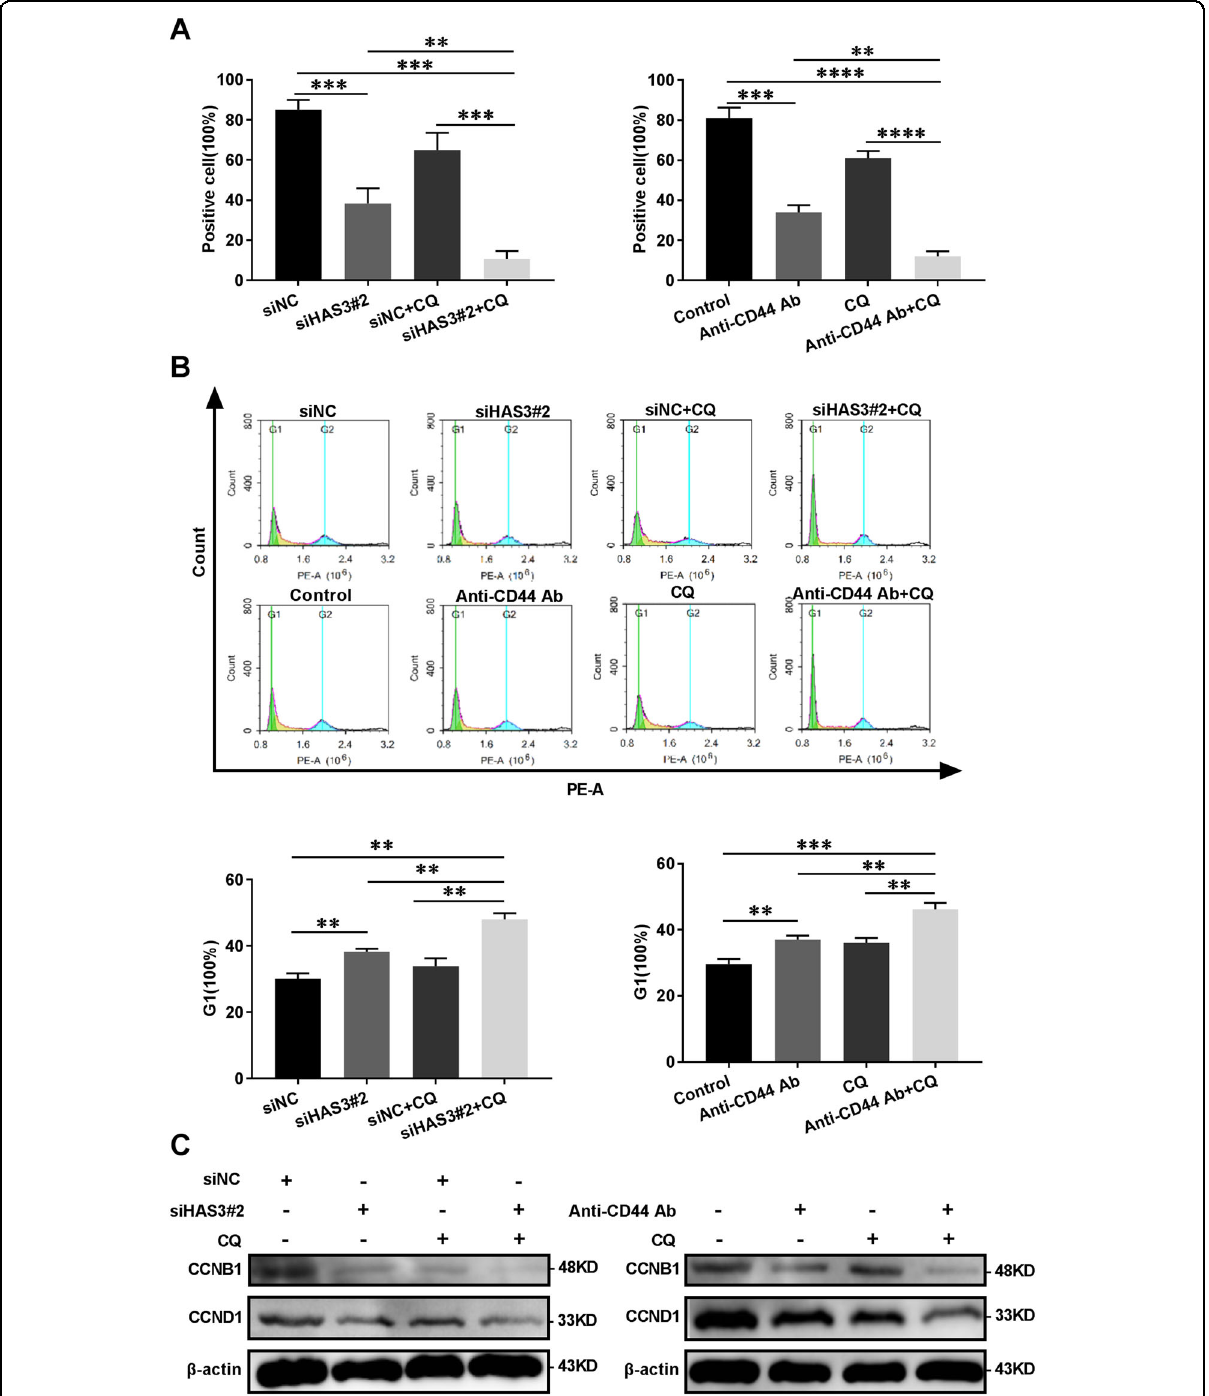
Fig. 5 Treatments interfering with HAS3 and CD44 combined with autophagy inhibitors have a synergistic effect on the glioma cell cycle. A The percentage of Ki67-positive U251 glioma cells was detected using immuno fl uorescence staining after transfection with the HAS3 siRNA or culture with a CD44 antibody, followed by treatment with CQ (30 μ mol/L) for 48 h. B The cell cycle distribution of U251 glioma cells was detected using fl ow cytometry after transfection with the HAS3 siRNA or culture with a CD44 antibody, followed by treatment with CQ (30 μ mol/L) for 48 h. (green: G0-G1, yellow: S, and blue: G2-M). C Relative levels of the CCNB1 and CCND1 proteins in U251 glioma cells transfected with the HAS3 siRNA or cultured with a CD44 antibody, followed by treatment with CQ (30 μ mol/L) for 48 h. The data are presented as the mean ± SD; * P < 0.05, ** P < 0.01, and *** P < 0.001, **** P <